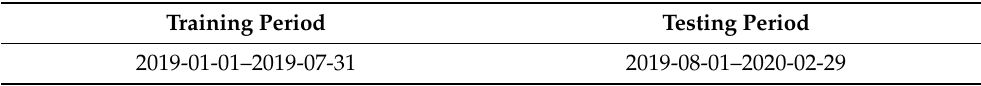
Table 9. Training and testing periods for Load Disaggregation